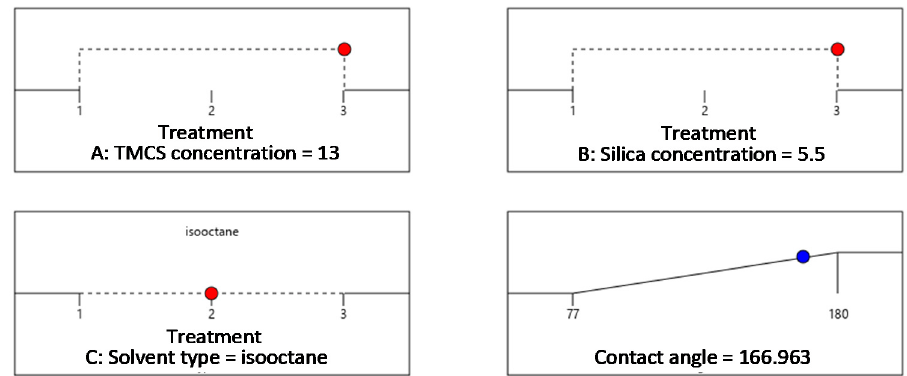
Figure 15. Optimization of the operating conditions of superhydrophobic coating using TMCS.